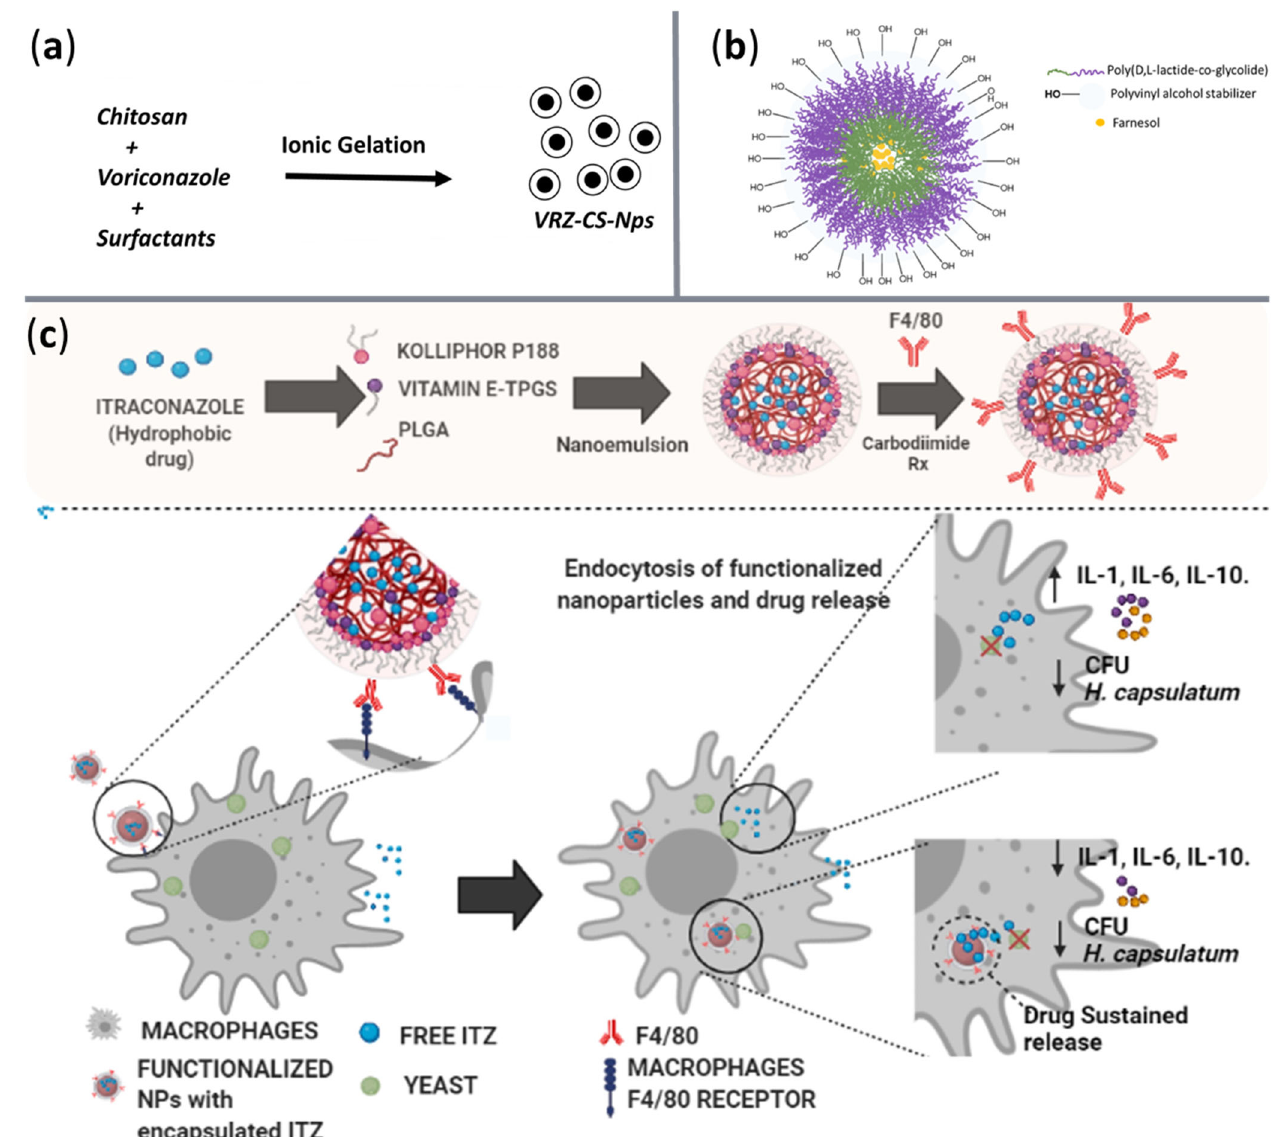
Figure 7. Visual representation of several nanosystems for antifungal agents’ delivery. ( a ) Chitosan- based NPs loaded with voriconazole. Adapted from an open-access source [111]. ( b ) PLGA NPs loaded with farnesol. Reprinted from an open-access source [114]. ( c ) PLGA NPs functionalized with anti-F4/80 antibodies loaded for itraconazole delivery. Reprinted from an open-access source [116].